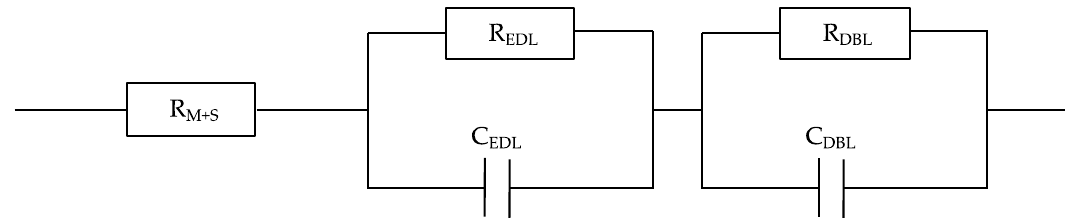
Figure 6. Equivalent circuit diagram showing the combination of membrane, electric double-layer, and diffusion boundary layer resistances.